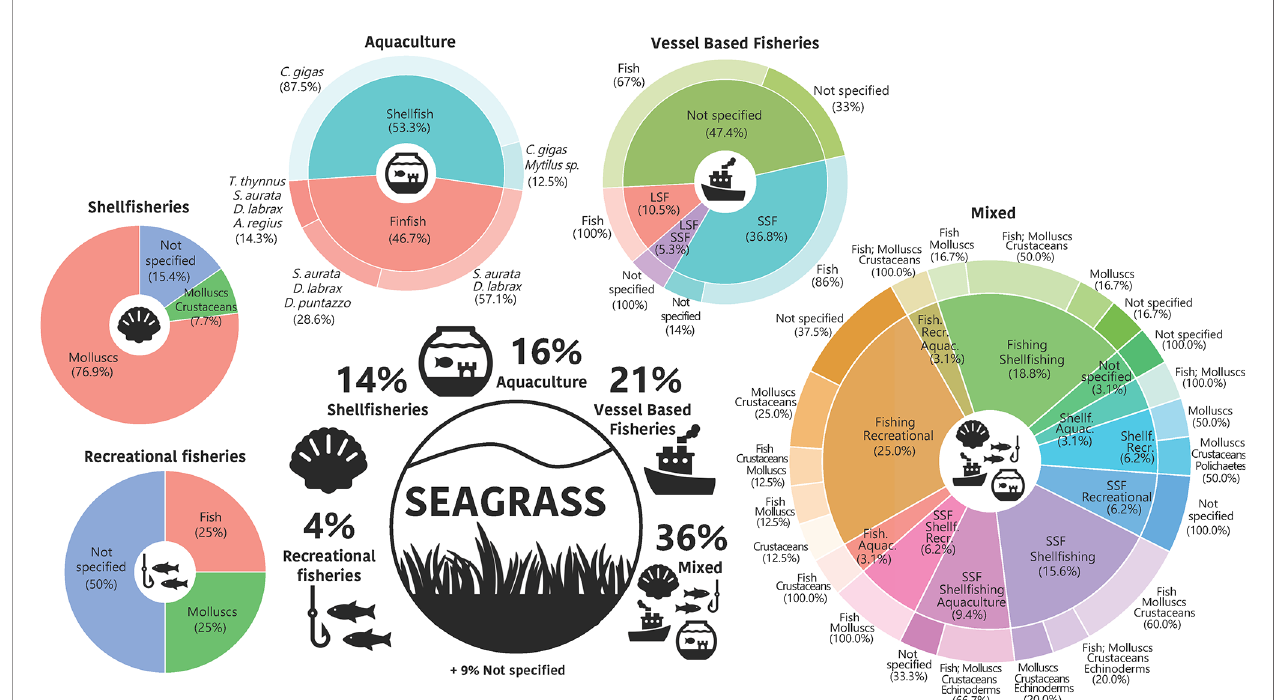
FIGURE 5 | Main fi sheries-related activities carried out on seagrass areas according to the literature synthesis. Fish, Vessel Based Fisheries; LSF, large-scale fi sheries; SSF, small-scale fi sheries; Aquac., Aquaculture; Shellf., Shell fi sheries; Recr., Recreational fi sheries; C. gigas, Crassostrea gigas (Thunberg, 1793); S. aurata, Sparus aurata (Linnaeus, 1758), D. labrax, Dicentrarchus labrax (Linnaeus, 1758); T. thynnus, Thunnus thynnus (Linnaeus, 1758); A. regius, Argyrosomus regius (Asso, 1801); D. puntazzo, Diplodus puntazzo (Walbaum,